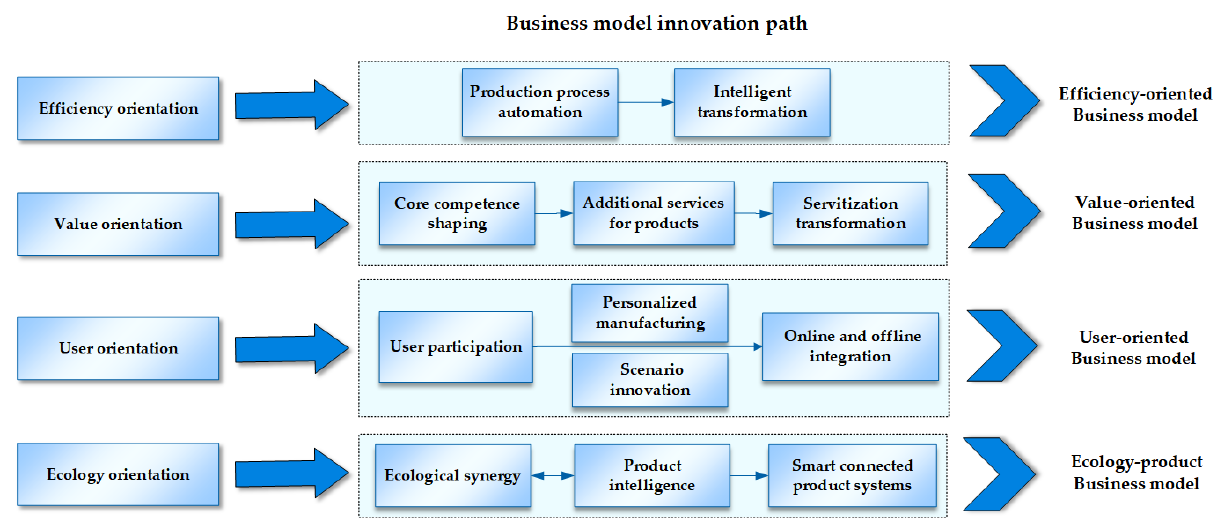
Figure 3. Research framework. Table 5. Selective coding results. Table 5. Selective coding results.